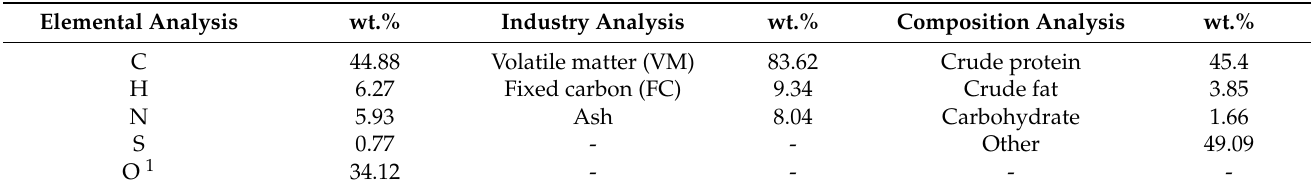
Table 3. Elemental analysis, industry analysis and composition analysis of PR (dry basis). Elemental